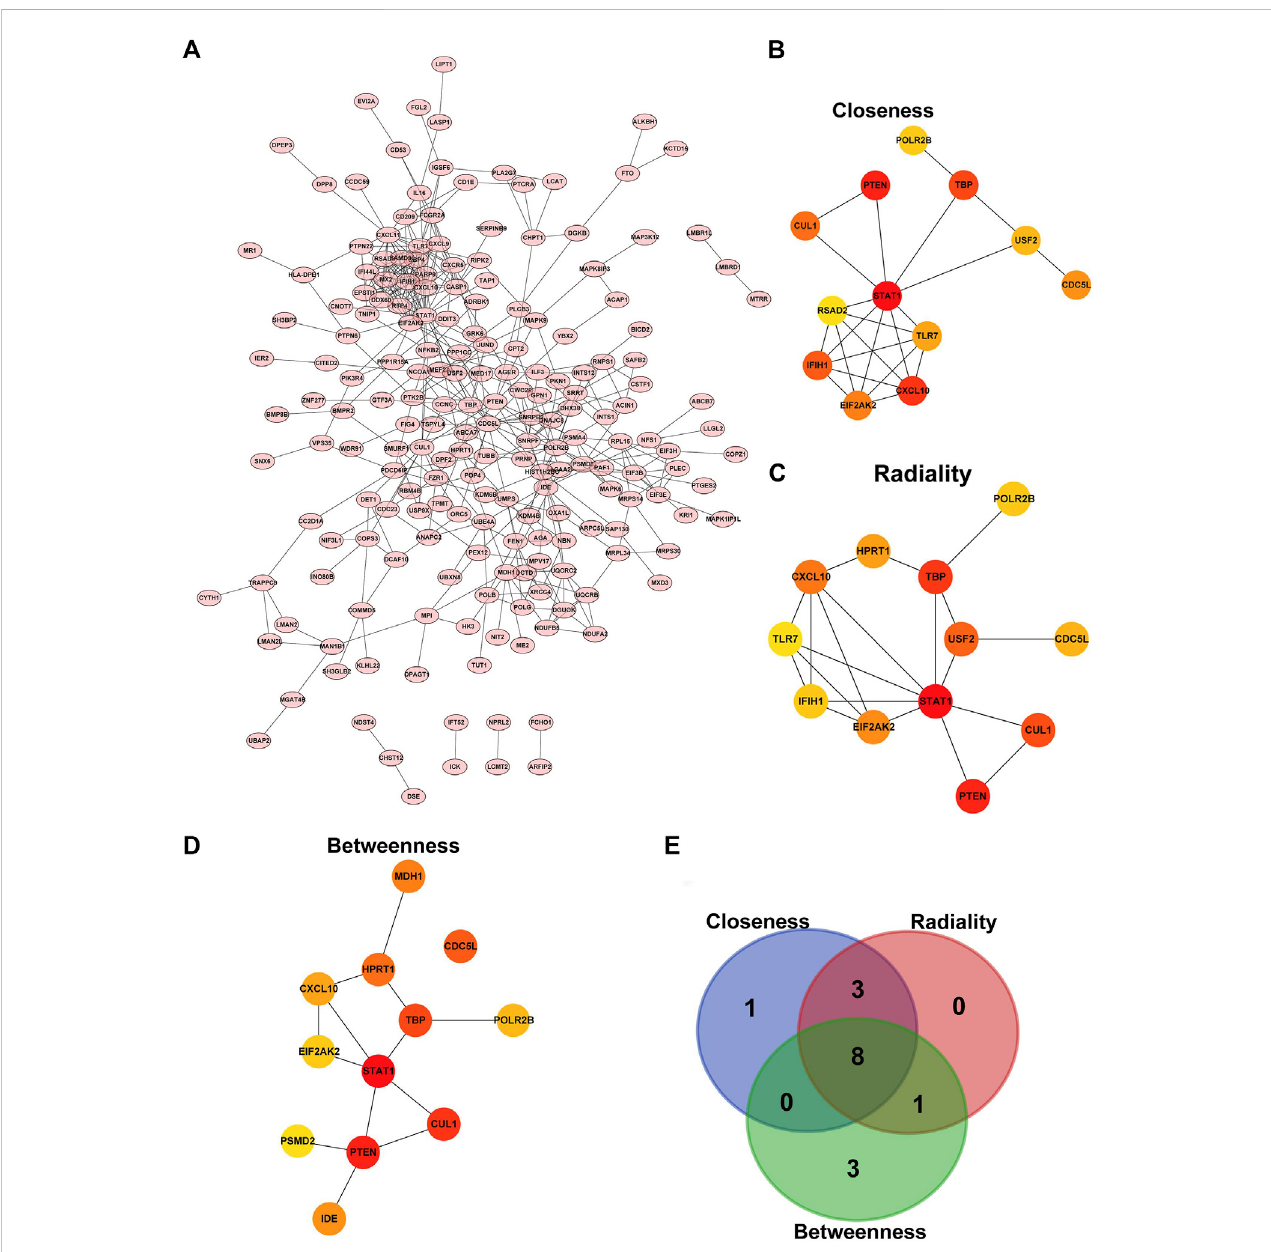
PPI network construction and identi fi cation of hub genes. (A) The protein – protein interaction network of the overlapped genes. (B) CytoHubba plug-in Closenessalgorithmidenti fi edtop12coregenes. (C) CytoHubbaplug-inRadialityalgorithmidenti fi edtop12coregenes. (D)